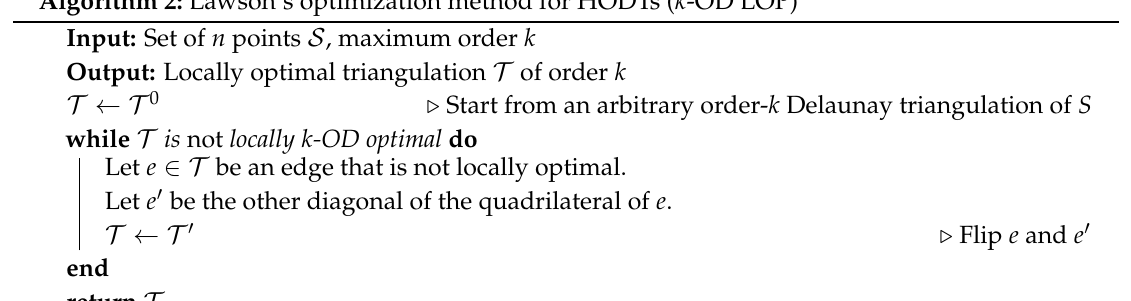
Algorithm 2: Lawson’s optimization method for HODTs ( k -OD